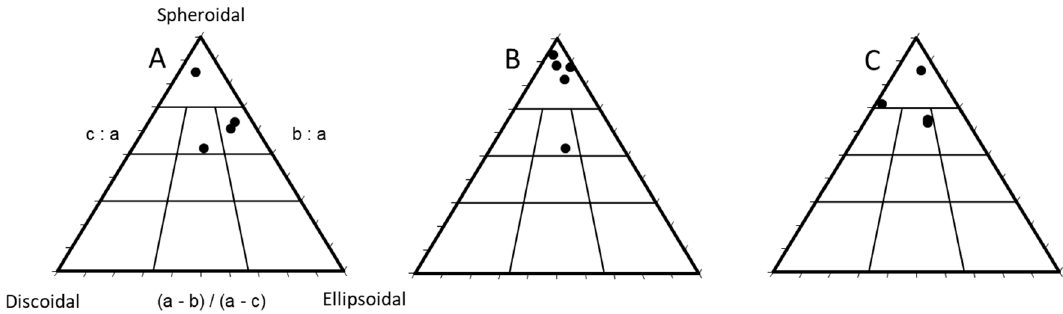
Figure 3. Degree of sphericity of the rhodoliths from the three dredge sites ( A–C ) off the Kei River mouth, South Africa ( n = 4 per site).